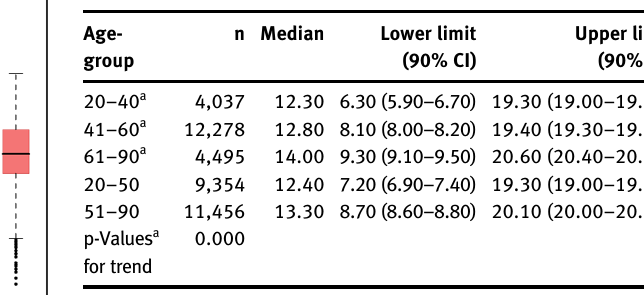
Table  : Reference intervals of Hcy for different age-group in total